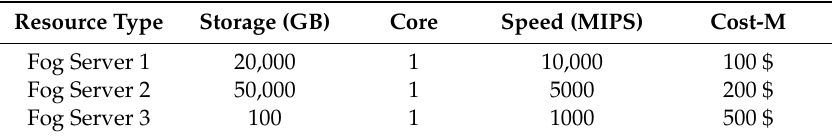
Table 3. Heterogeneous fog server resource specification.